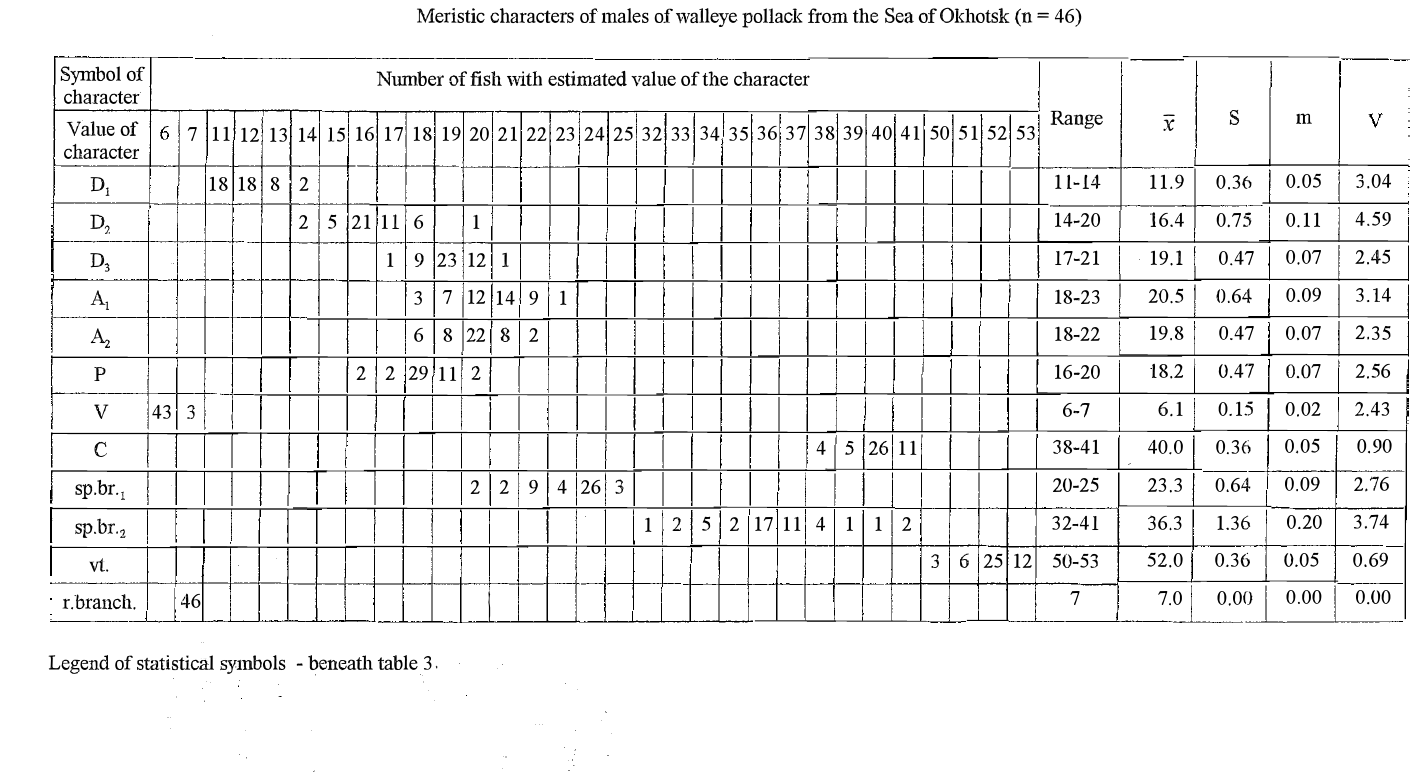
Number offish with estimated value of the character character